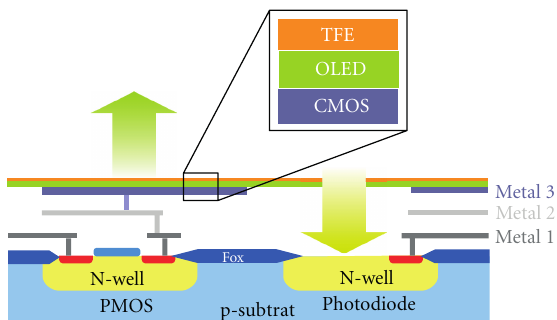
Figure 2: Cross-section of the bi-directional OLED-on-CMOS- microdisplay